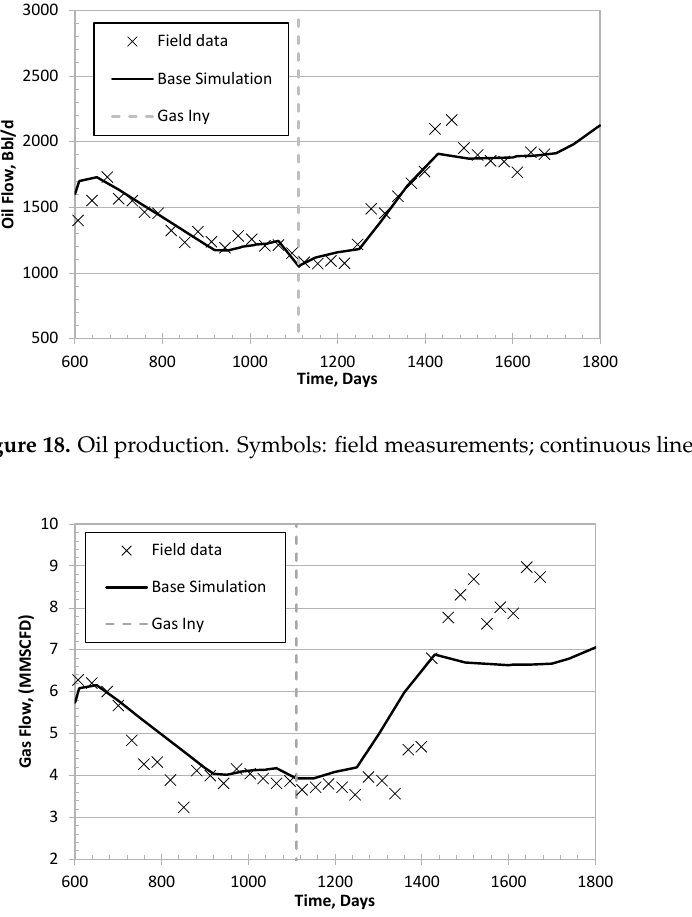
Figure 19. Gas production. Symbols: field measurements; continuous line: baseline. Once the historical matching has been verified, different gas injection is evaluated from day 1423: CO 2 , Flue gas , and recycle gas at a fixed rate of 12 MMSCF/day. Figures 21 and 22 show the simulation results for oil and gas, respectively, with the different injection gases, where it is observed that CO 2 is the gas with the best productivity